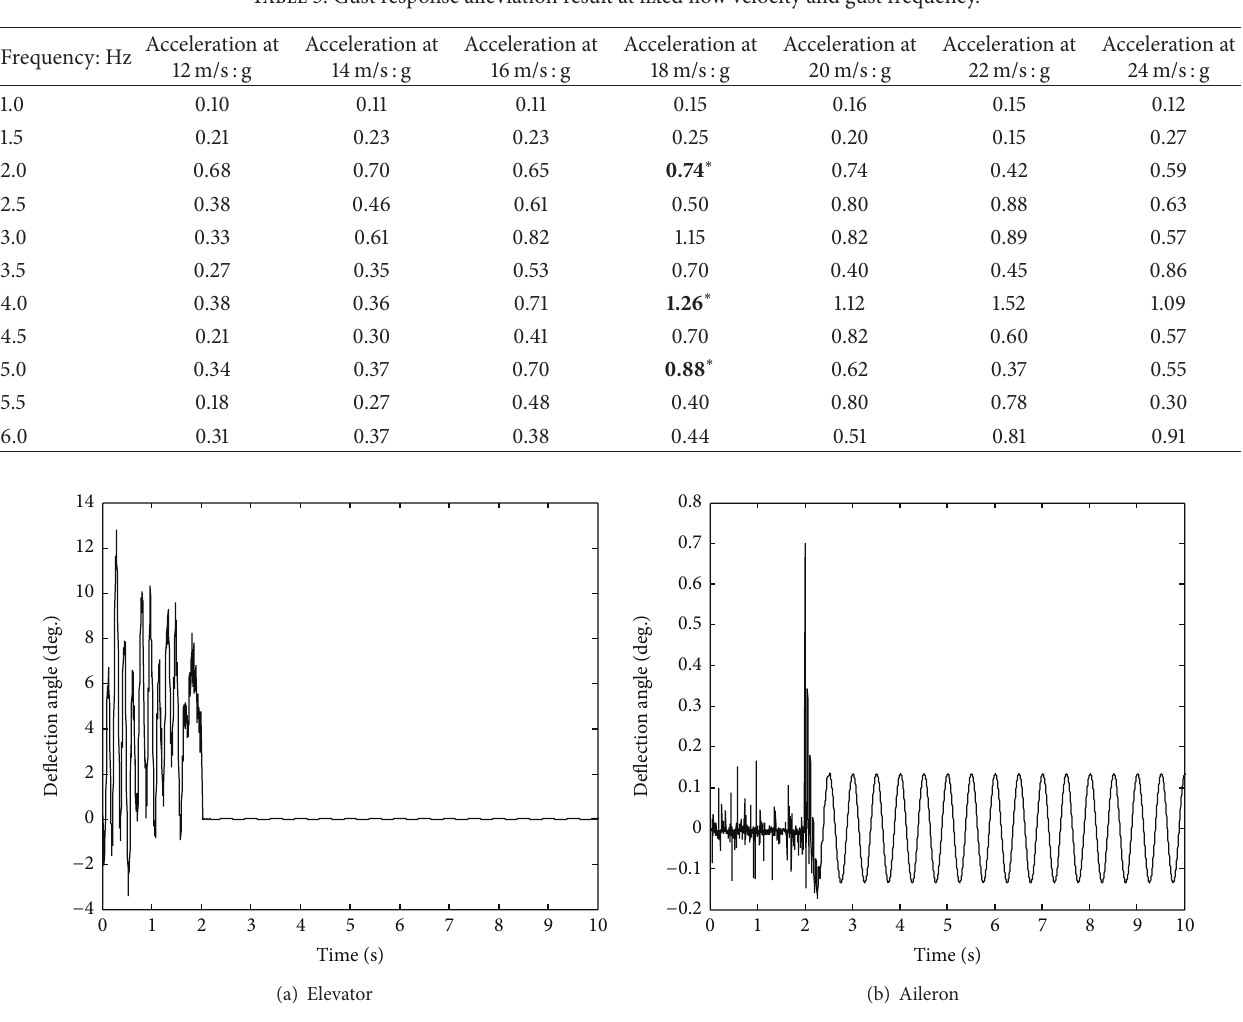
Figure 6: Deflections of control